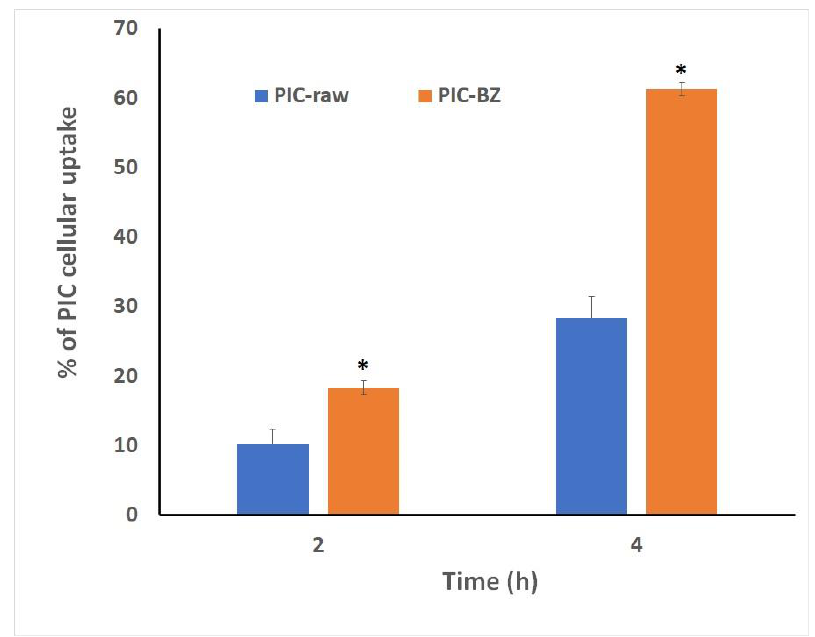
Figure 6. Cellular uptake of PIC from PIC raw and optimized PIC-BZ at 2 and 4 h. Data represent mean of six independent replicates SD. * Significantly different ( p < 0.05) determined by Student’s t